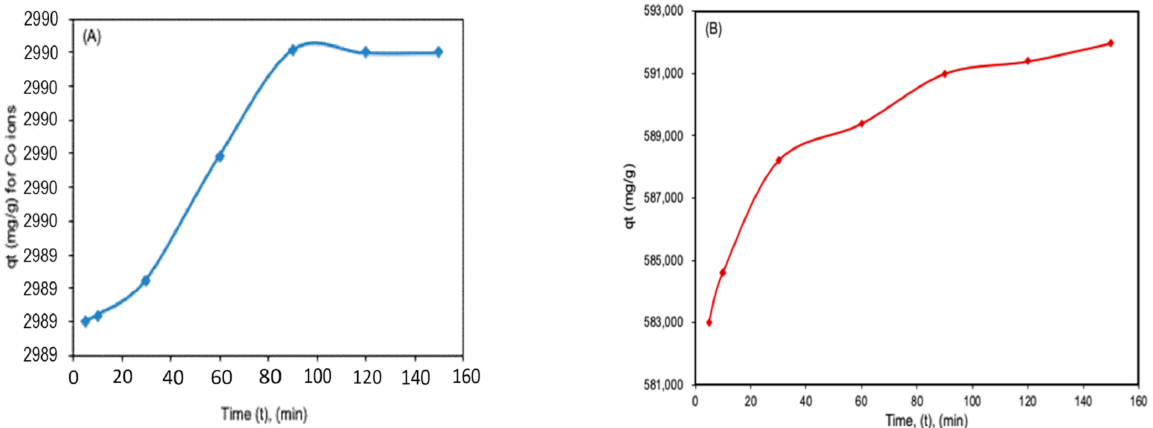
Figure 3. Effect of contact time on the adsorption of Co 2+ ( A ) and TCE ( B ). Conditions: C o = 10 ppm, m (adsor- bent dose) = 0.0005 g (for TCE) and 0.1 g (for Co 2+ ), time = 24 h, pH (TCE) = 2; pH (Co 2+ ) = 7.5, V = 30 mL, and temperature = 25 ◦ C and speed = 200